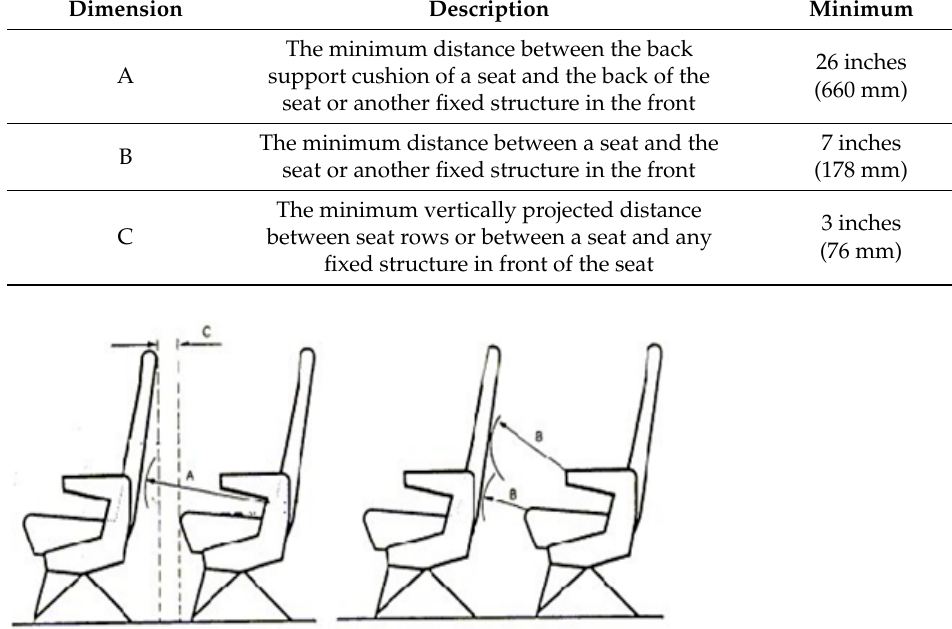
Table 3. Distancing of aircraft seats [23].